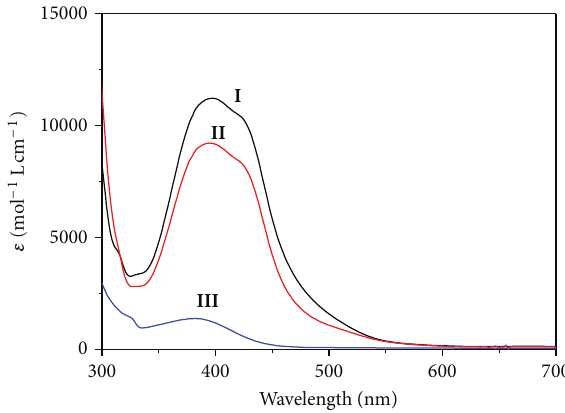
F 2: Electronic spectra in CH